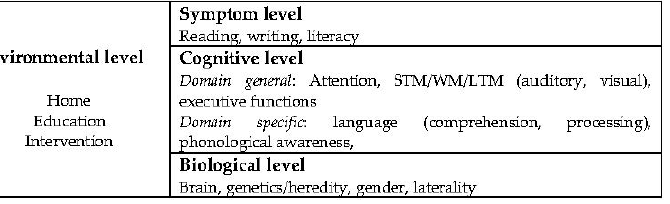
Figure 1. Basic causal model. From Morton and Frith [39]. Notes: levels (in bold) refer to the original model form Morton and Frith [39]. Descriptions of each level from Helland [40].